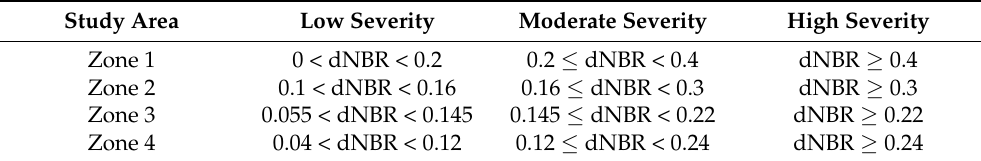
Table 4. Classification of different fire